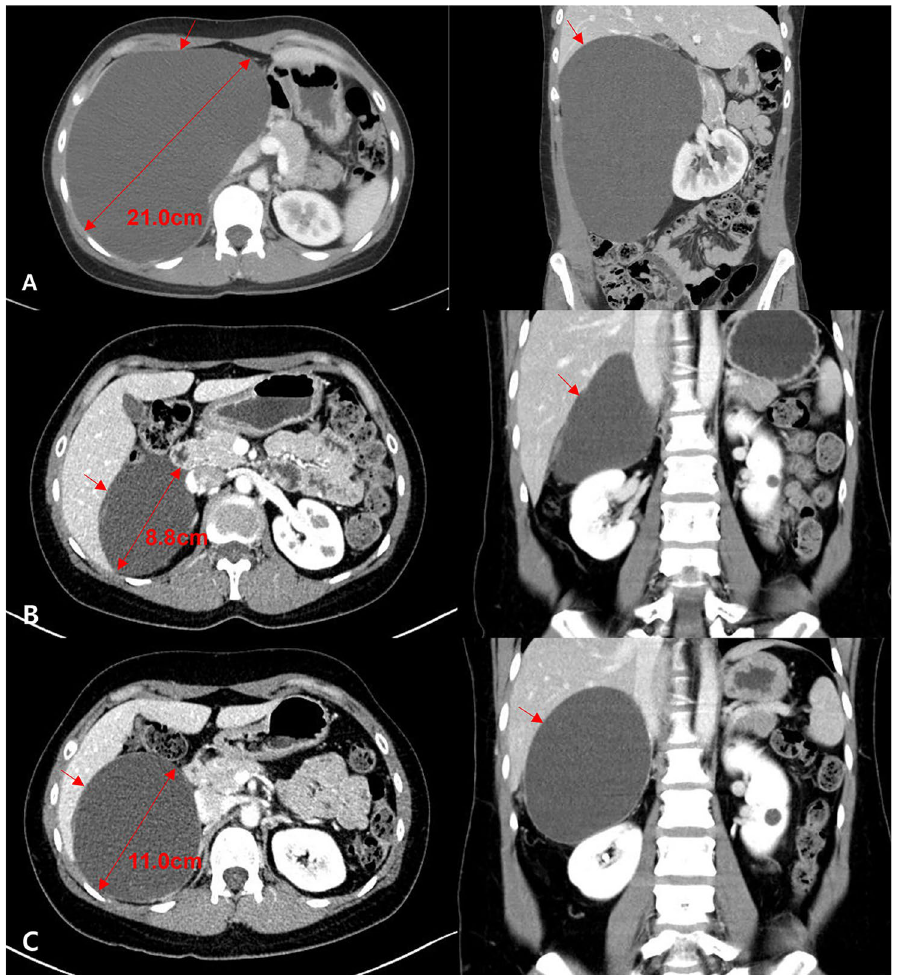
Figure 5. Axial and sagittal computed tomography (CT) imaging of Patient No. 6 ( A ) prior to treatment, ( B ) 3 months after RFA treatment, and ( C ) 12 months after RFA treatment, at the time of cyst